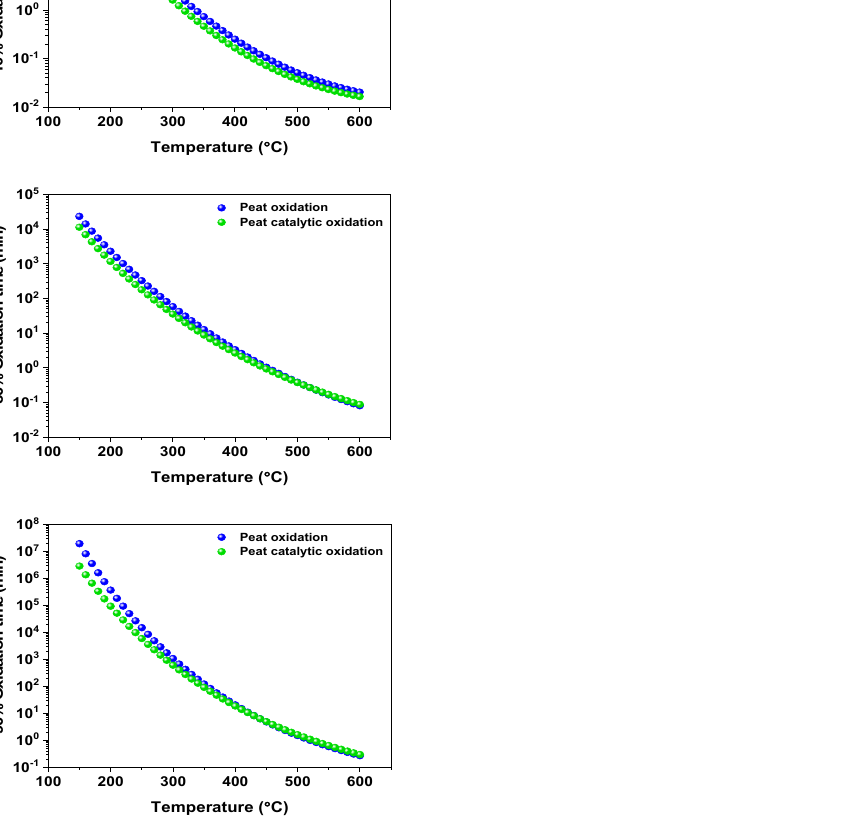
Figure 9. Calculated oxidation times of peat in the presence and absence of catalysts at 10%, 50%, and 90% oxidation conversions.